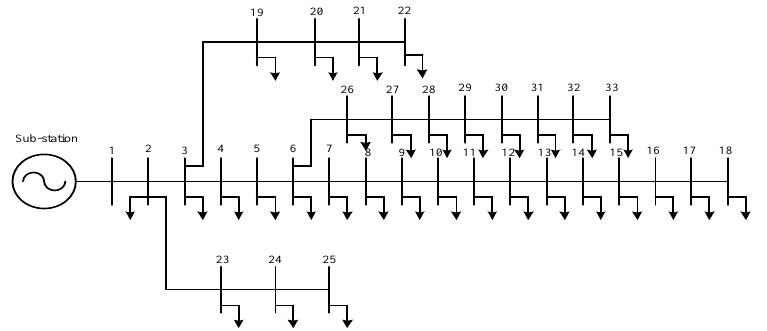
Figure 2. Single line diagram for IEEE 33-bus radial distribution network.